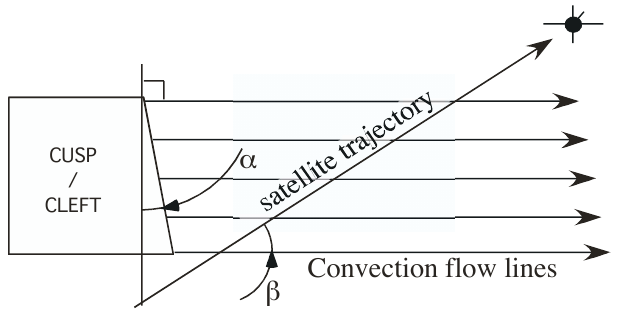
Fig. 2. Illustration of the satellite trajectory orthogonal to the plasma flow. The important parameters defining the uncertainty in a velocity dispersion analysis are the angles α (flow – source angle) and β (spacecraft trajectory – flow